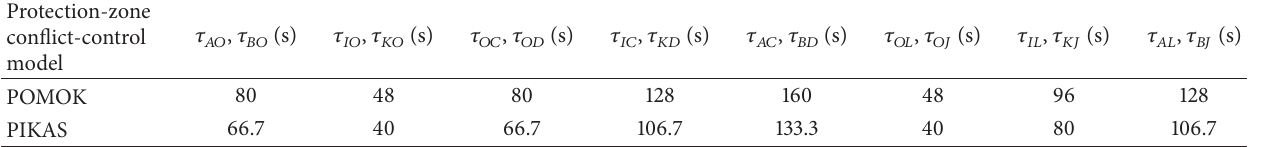
Table 3: The sojourning times in the places of two protection-zone conflict-control